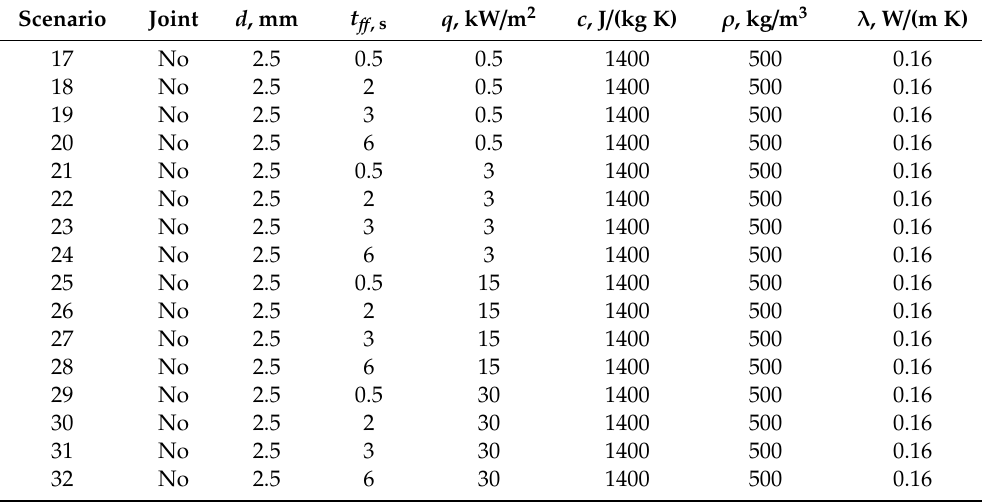
Table A2. The Main Scenarios of Forest Fire Impact on a Stem without a Joint. Part